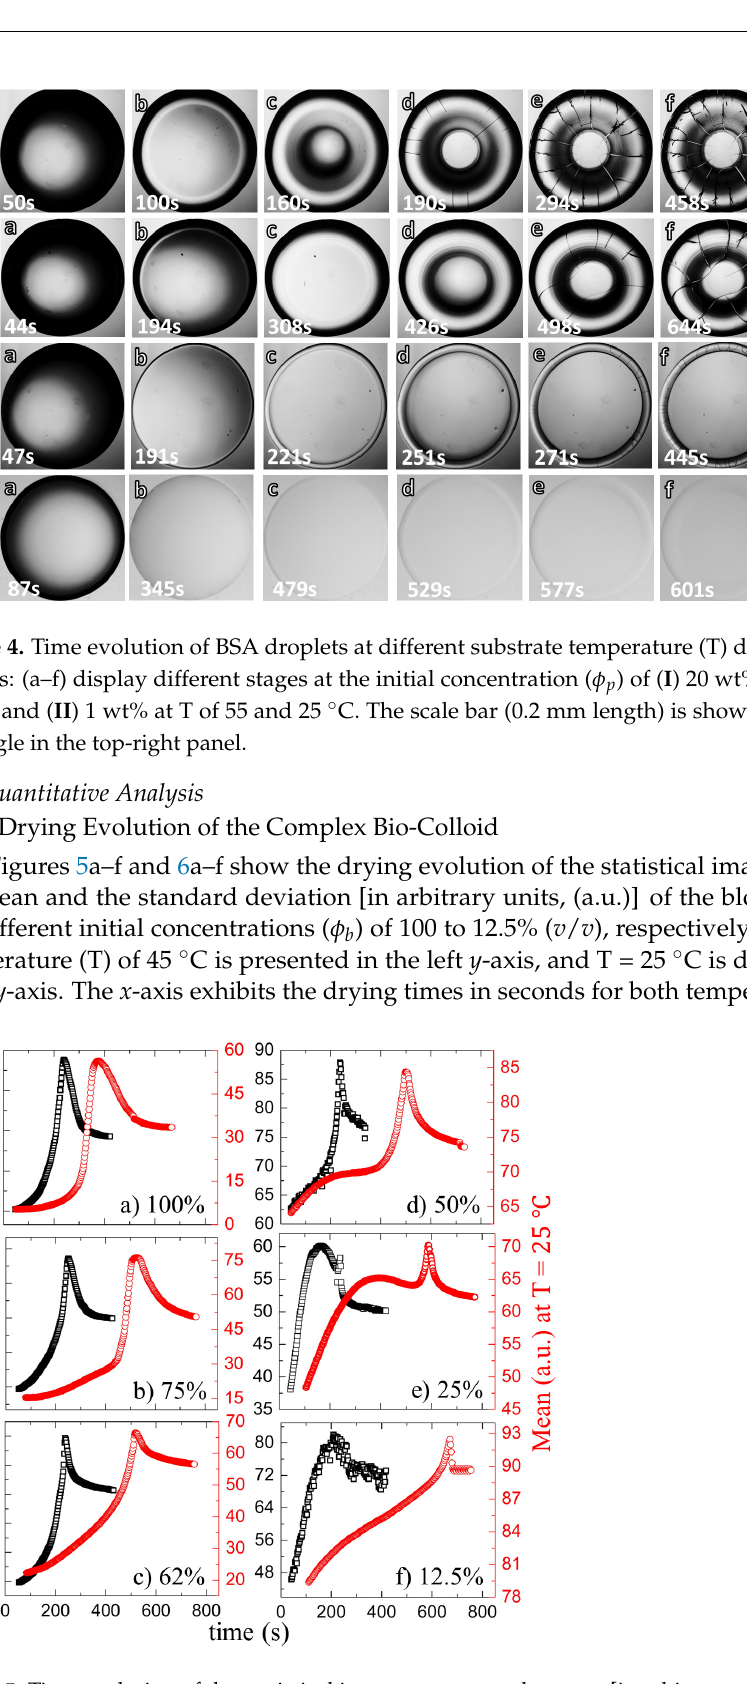
Figure 5. Time evolution of the statistical image parameter, the mean [in arbitrary units, (a.u.)] of the blood droplets at the different initial concentrations ( φ b ) of 100 to 12.5% ( v / v ), respectively, in ( a – f ). The black and the red colors represent the mean at 45 and 25 ◦ C